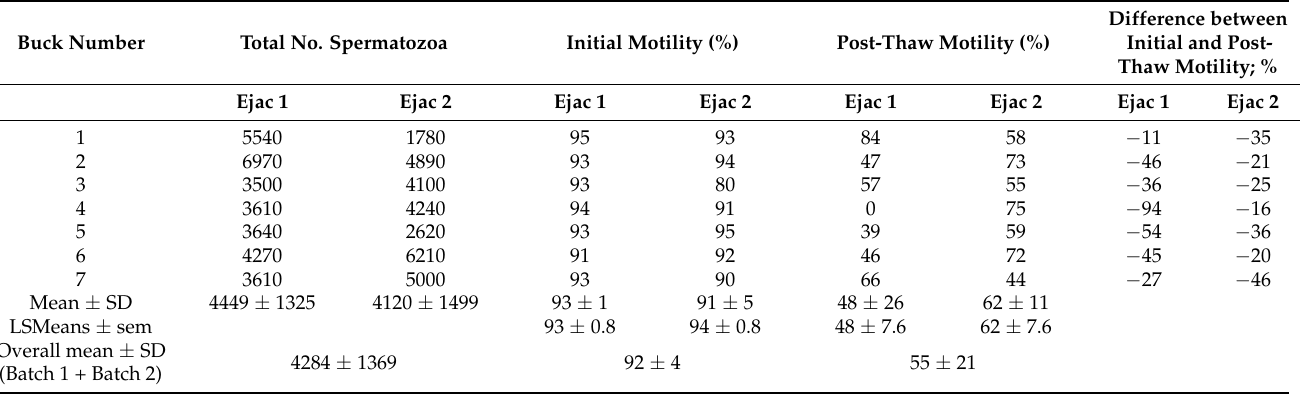
Table 2. Characteristics (LSMeans ± sem and Mean ± SD) of buck semen: total number of spermato- zoa, initial motility and post-thaw motility (n = 7 bucks).